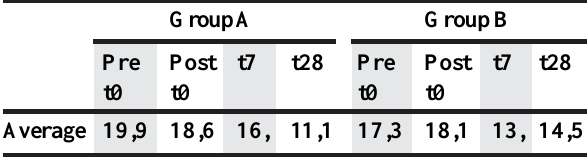
TABLE 3 - Animals of group A (with papilla dilation) and group B (sham), according to the values of average basal pressure (mmHg), evaluated before (pre t0) and immediately after (post t0) the dilation or sham of first procedure and in the complementary procedures (t7 and